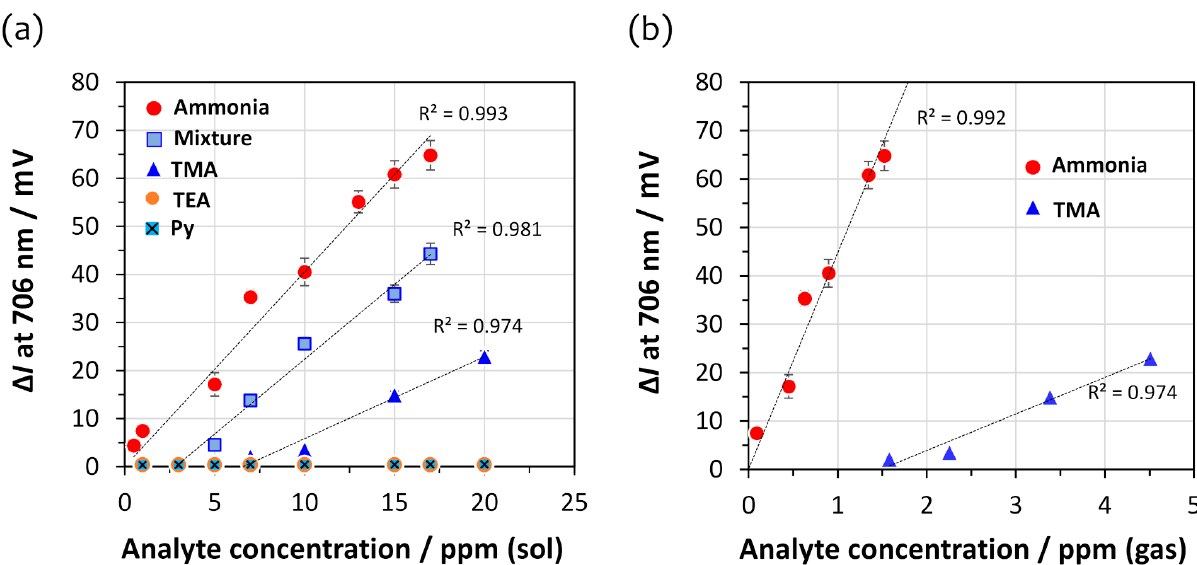
Figure 5. Calibration curves for the intensity change ( ∆ I as sensor response, n = 3) at 706 nm of the 5-cycle DAR/TSPP+PSS (0.025 wt%) film sensor ( a ) at different solution concentrations of ammonia, TMA, TEA, Py, and a mixture of all four analytes (equal concentrations in the range of 0–17 ppm for each), and ( b ) at different gas concentrations of ammonia and